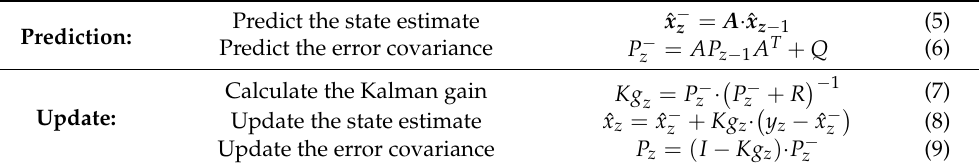
Table 1. Kalman filter iterative